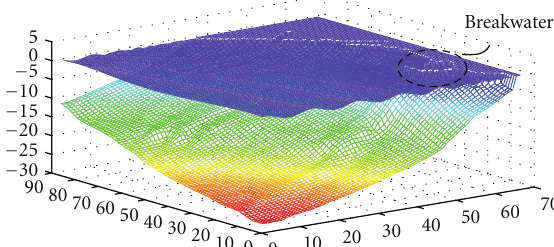
Table 1: Parameters used for the small